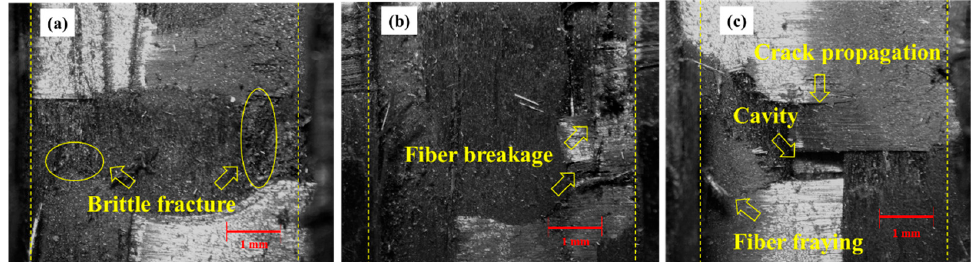
Figure 8. Microscope image of the machined slot at higher cutting speed for ( a ) 1 wt.% GO, ( b ) 2 wt.% GO, and ( c ) 3 wt.% GO.